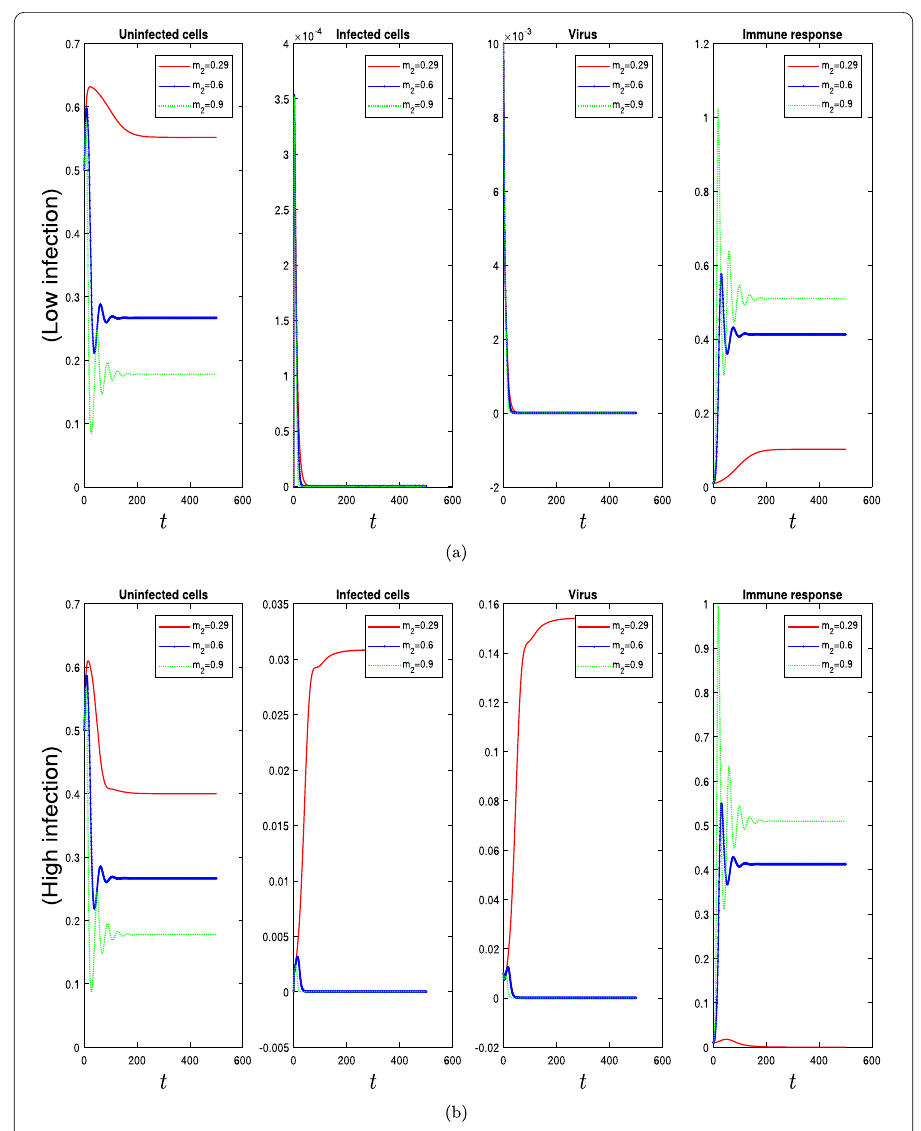
Figure 10 Numerical simulations of model (2) with initial values: x (0) = 0.5, y (0) = 0, v (0) = 0.01, and z (0) = 0.01, showing the time variation in each compartment of the model with varying values of m 2 as shown in the legend (other parameters are set as in (11) except n = 0.16). The simulations are carried out for two cases of infection rate, ( a ) low infection ( a = 0.1) and ( b ) high infection ( a =